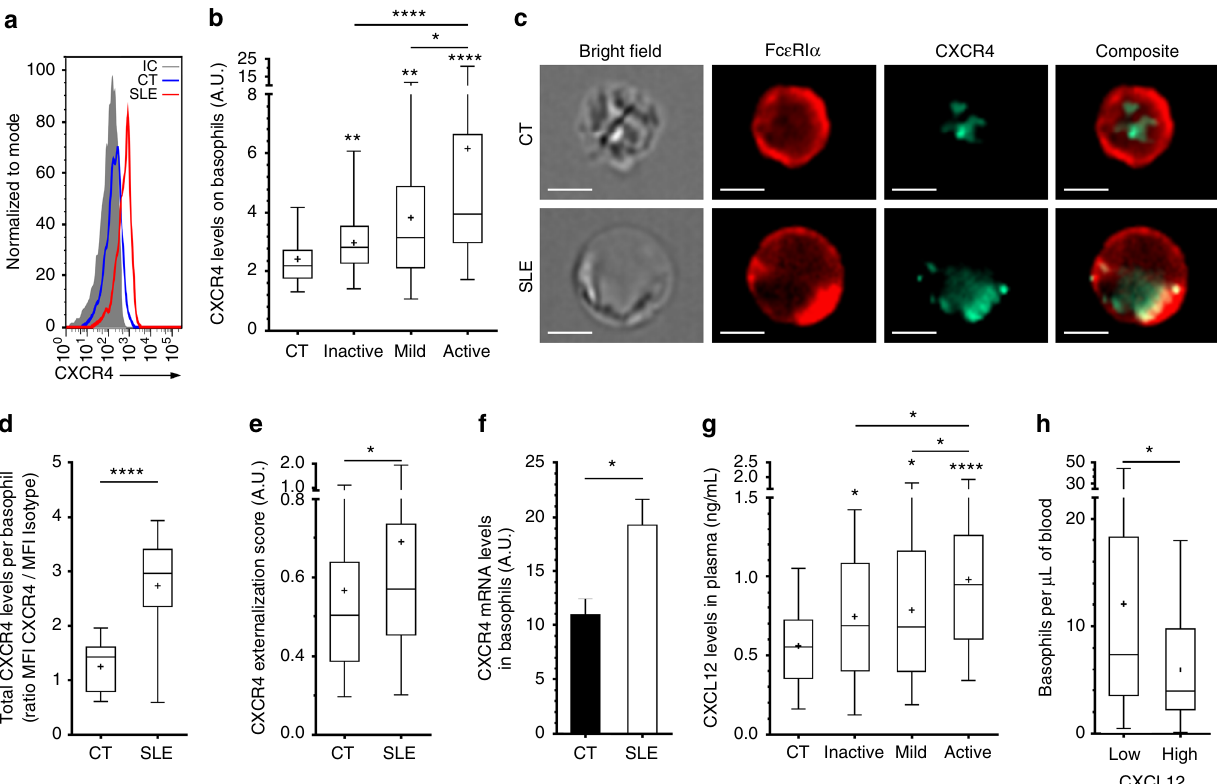
Fig. 2 CXCL12-CXCR4 axis is associated with basopenia in SLE. a Representative FACS analysis of CXCR4 levels on blood basophils as in Fig. 1b. b CXCR4 levels on blood basophils as in Fig. 1a ( n = 95/32/24/ 70, respectively). c Representative images of CXCR4 (green) and Fc ε RI α (red) expressions by CT or active SLE patient basophil captured by imaging fl ow cytometry (scale bar = 5 µ m). d Total CXCR4 expression and e CXCR4 externalization score in basophils from CT ( n = 3) and active SLE patients ( n = 4) as in ( b ) (20 basophils per individual). f CXCR4 RNA transcript expressions in basophils as in Fig. 1d. g CXCL12 levels in plasma from patients as in Fig. 1a ( n = 78/45/38/ 87, respectively). h Basophils per µ L of blood in patients with active SLE grouped by low ( n = 59) or high ( n = 22) CXCL12 plasma levels as de fi ned in Fig. 1h. b, d, e, g, h Data are presented as median and interquartile ranges with whiskers representing 5 – 95 percentiles and the mean presented as a “ + ” symbol. Statistical analyses were by Mann − Whitney tests. f Data are presented as mean ± s.e.m. Statistical analyses were by unpaired Student t tests. b , d − h NS: not signi fi cant, * P < 0.05, ** P < 0.01, *** P < 0.001, **** P < 0.0001. Comparison to control group is shown above each bar and to the corresponding bars when indicated. A.U. arbitrary